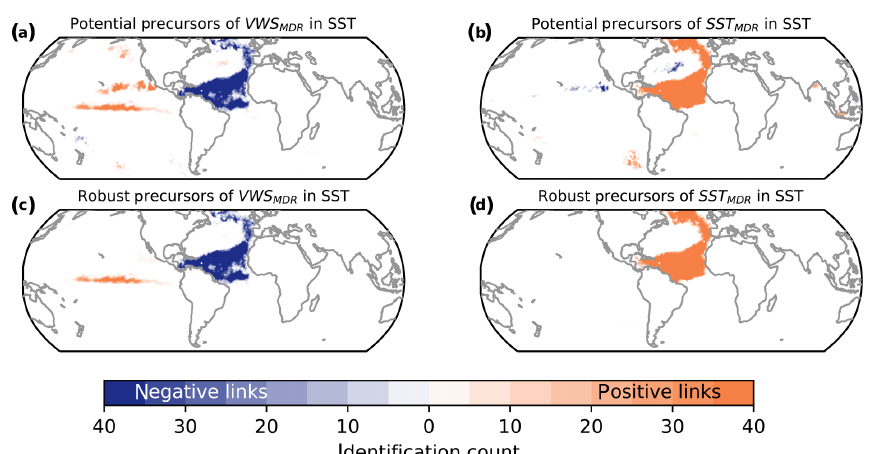
Figure 4. Potential and robust precursors of VWS MDR (a, c) and SST MDR (b, d) in May. Number of training sets in which a grid cell is part of a potential (a–b) and robust (c–d) precursor region. The maximum number is 40 – the number of different training sets